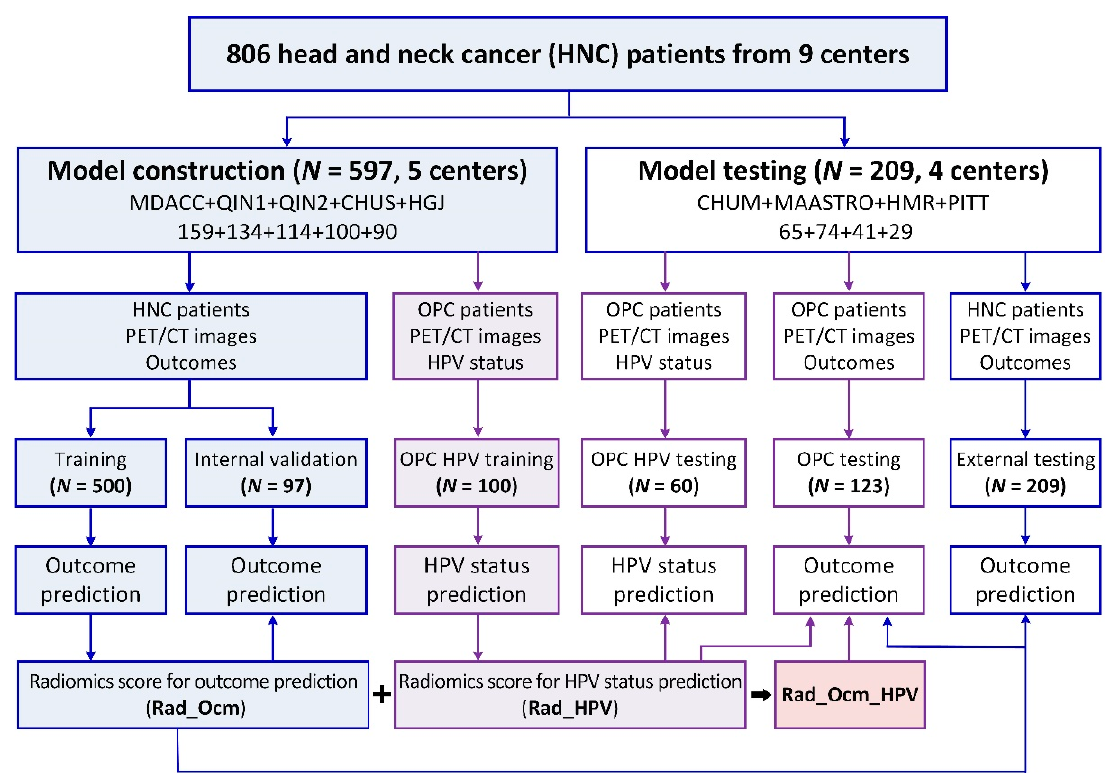
Figure 1. Our model construction and testing paradigms in this radiomics study.